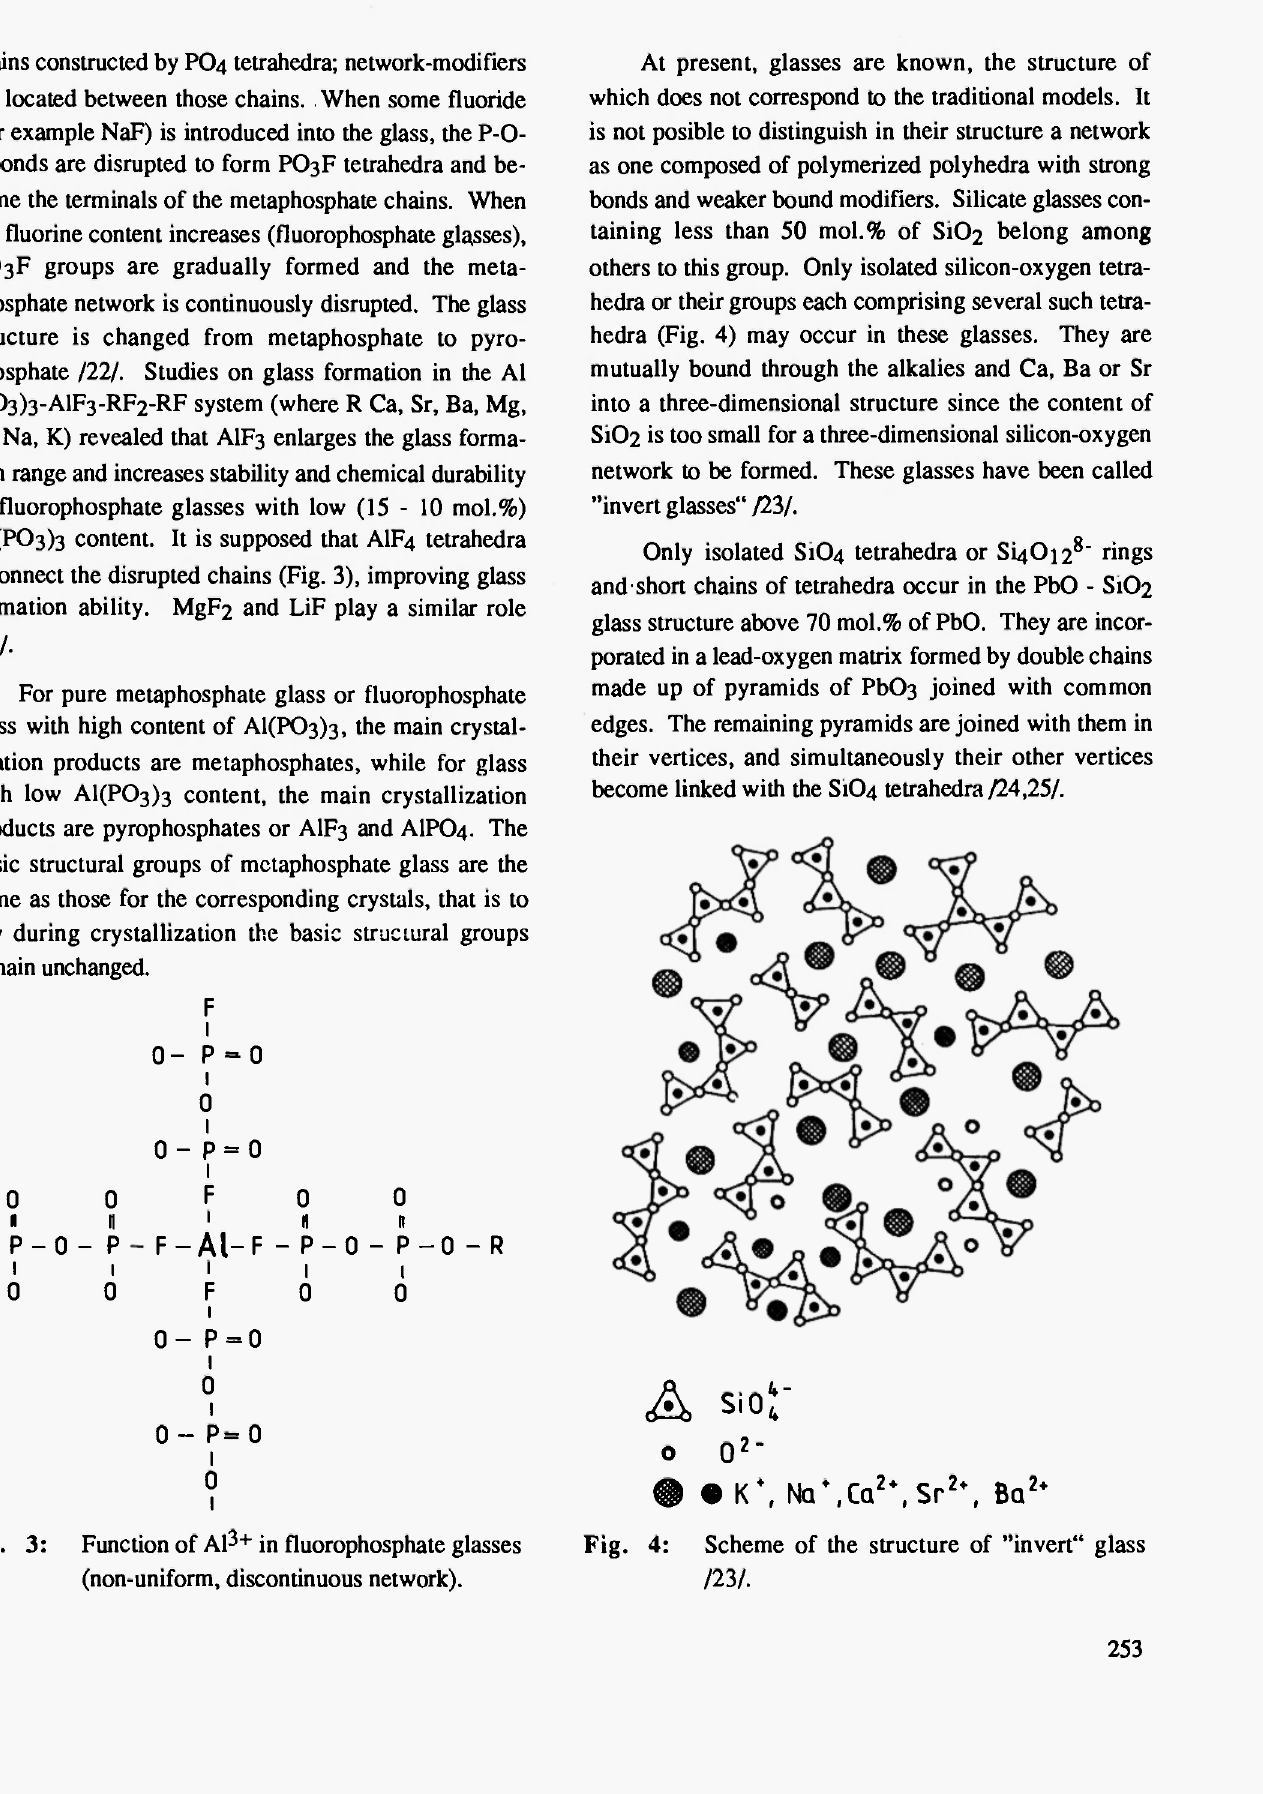
Fig. 3: Function of Al 3+ in fluorophosphate glasses (non-uniform, discontinuous network).